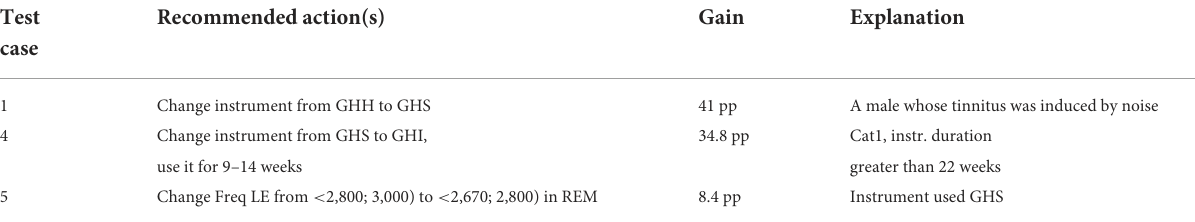
TABLE 9 Results on recommending treatment actions, characterized by an expected improvement gain in percentage points and explanation(s) for the patients’ test